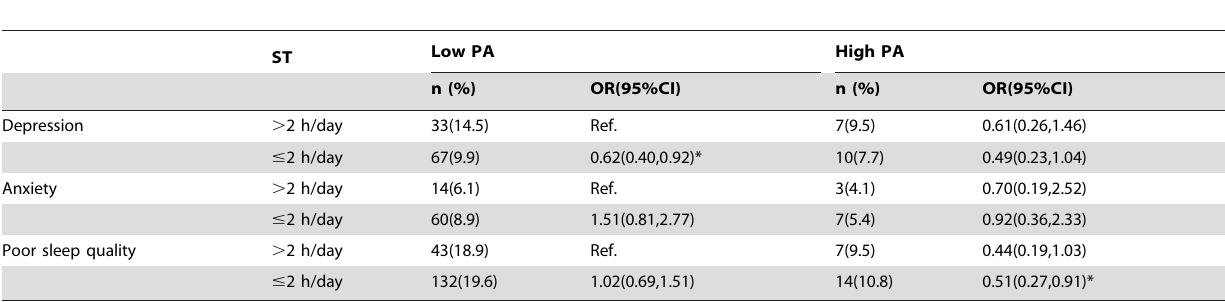
Table 3. Multivariate logistic regression for depression, anxiety, and sleep quality by combined physical activity and screen time among Chinese college